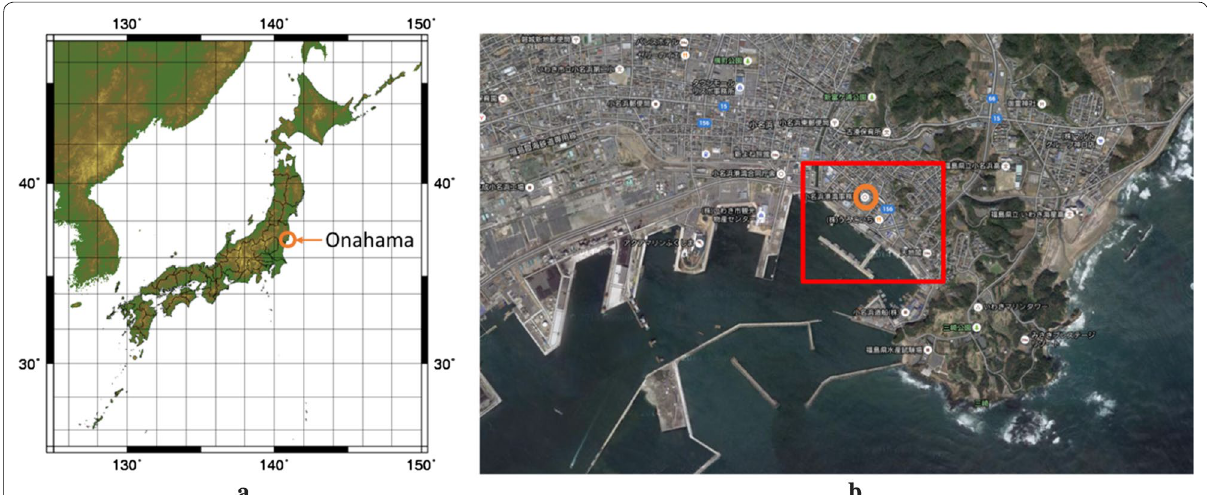
Fig. 1 Location of the target site of this study, a Onahama, Fukushima, Japan, and b Onahama Port Office of MLIT, denoted by orange circles . The red rectangle denotes the target area of this